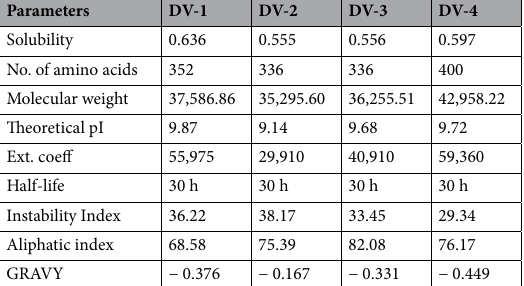
Table 9. Physicochemical properties of the predicted multi-epitope based vaccine construct.